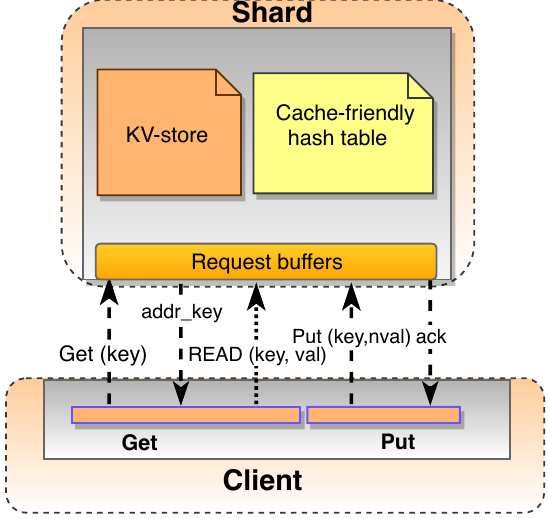
Figure 15. HydraDB schematic view. Dotted line represent the READ and dashed line represents the WRITE .